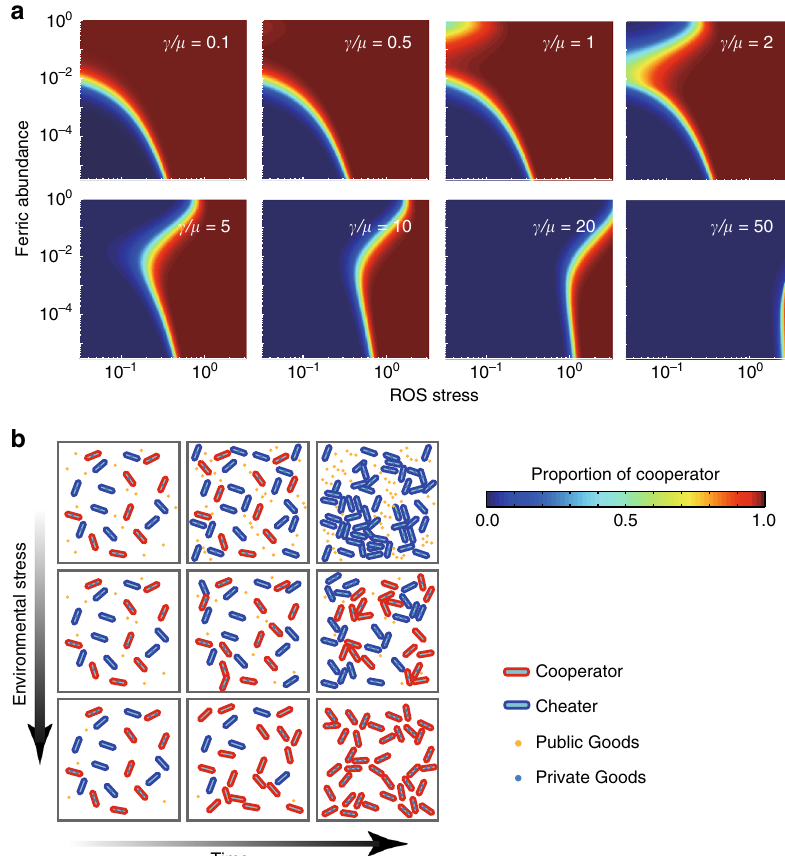
Fig. 5 Evolutionary outcomes dominated by different strategies. a Theoretical calculations show γ = μ dependence of producer fractions as a function of the abundance of ferric ions and the normalized environmental stress, where γ = μ ranges from sel fi shness ( γ = μ = 0.1) to loyal cooperation ( γ = μ = 50). b Schematic showing that conditional privatization stabilizes bacterial cooperation in the presence of environmental